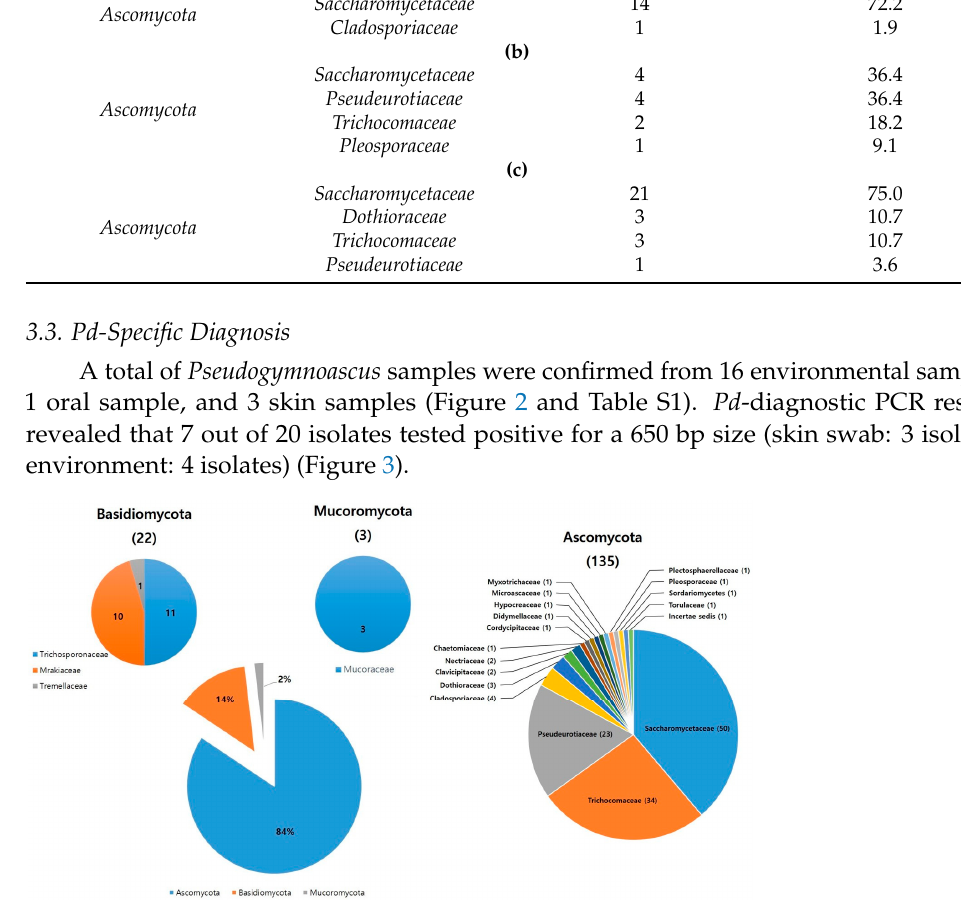
Figure 2. Fungal diversity frequencies by phylum and family. One hundred and fifty-four fungal colonies were isolated. Ascomycota was the most dominant (84%).